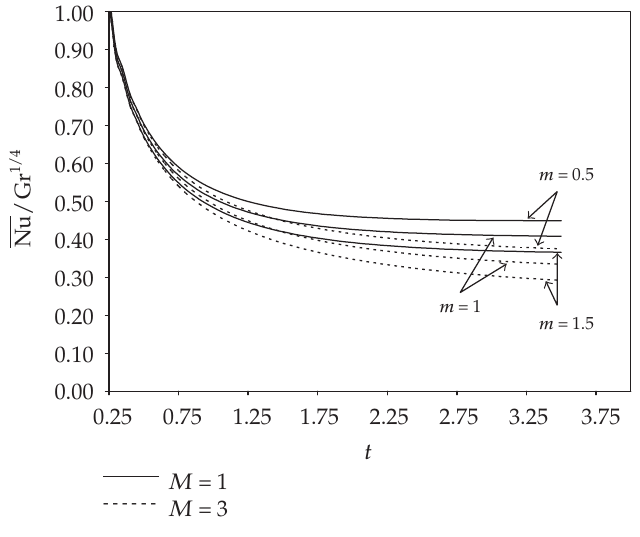
Figure 5.18 . The e ff ect of M and m parameters on average Nusselt number at F = 0 . 01 and Pr = 0 .